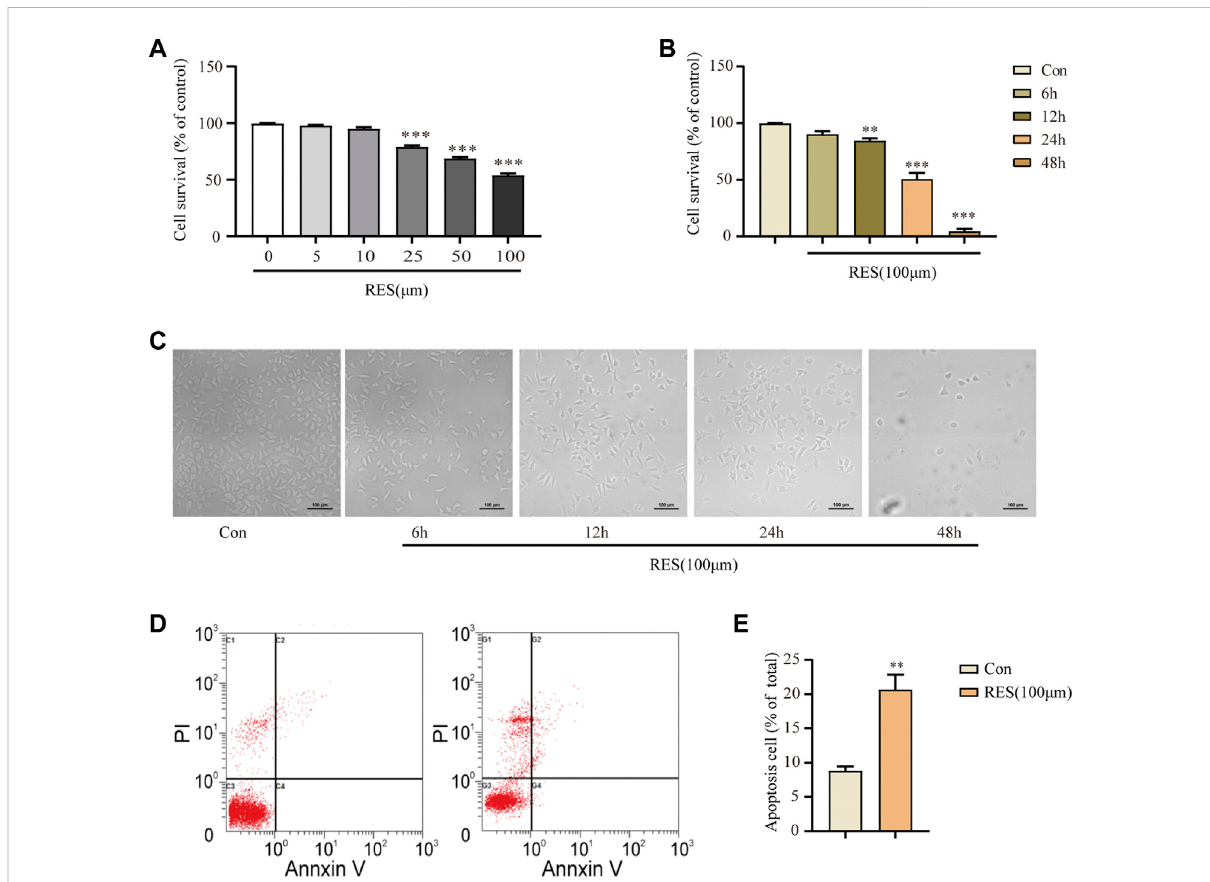
FIGURE 1 Reserpine treatment in SH – SY5Y cells induced apoptosis. (A) The cell survival in SH – SY5Y cells decreased with increasing concentration of reserpine by CCK8 assay ( n = 4 for each group, one-way ANOVA with Dunnett post hoc test, *** p < 0.001 vs. control). (B,C) The cell survival decreased with time in SH – SY5Y cells treated with 100 μ M reserpine by CCK8 assay ( n = 4 for each group, one-way ANOVA with Dunnett post hoc test,** p < 0.01,*** p < 0.001vs.control). Representative imagesare shownin (C) . (D,E) Flowcytometryshowed that apoptosis rateincreased in SH – SY5Y cells treated with 100 μ M reserpine for 24 h ( n = 4 for each group, student t-test, ** p < 0.01 vs. control). All data are expressed as mean ± SEM; Con, control; RES, reserpine; h,